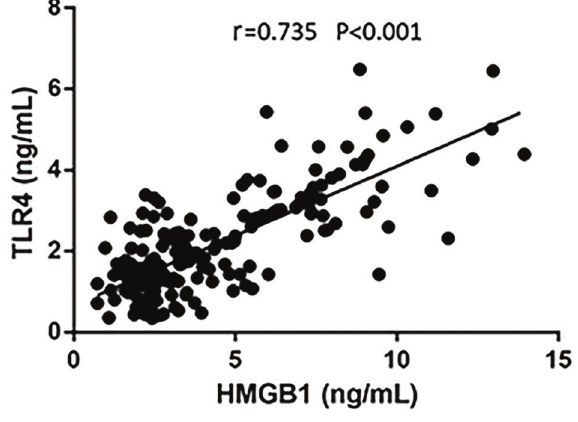
Figure 3. Correlation between HMGB1 and TLR4 determined by Spearman ’ s test. TLR4, toll-like receptor 4; HMGB1, high-mobility group box-1.